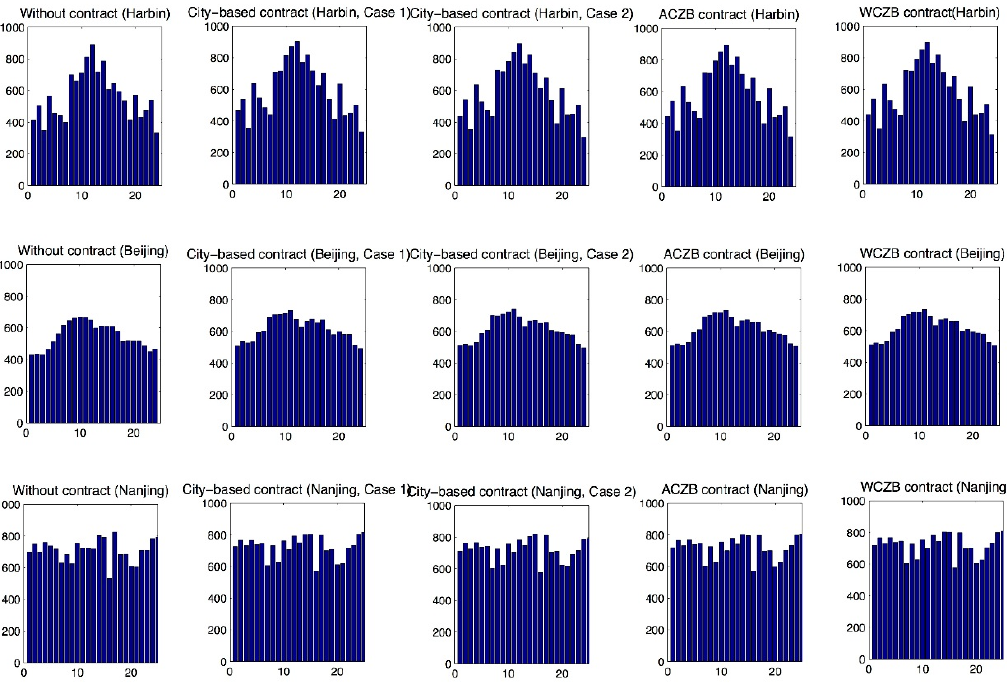
Figure 2. Histograms: revenue distributions without GDD contracts, with the city-based contracts, with the ACZB contracts and with the WCZB contracts.